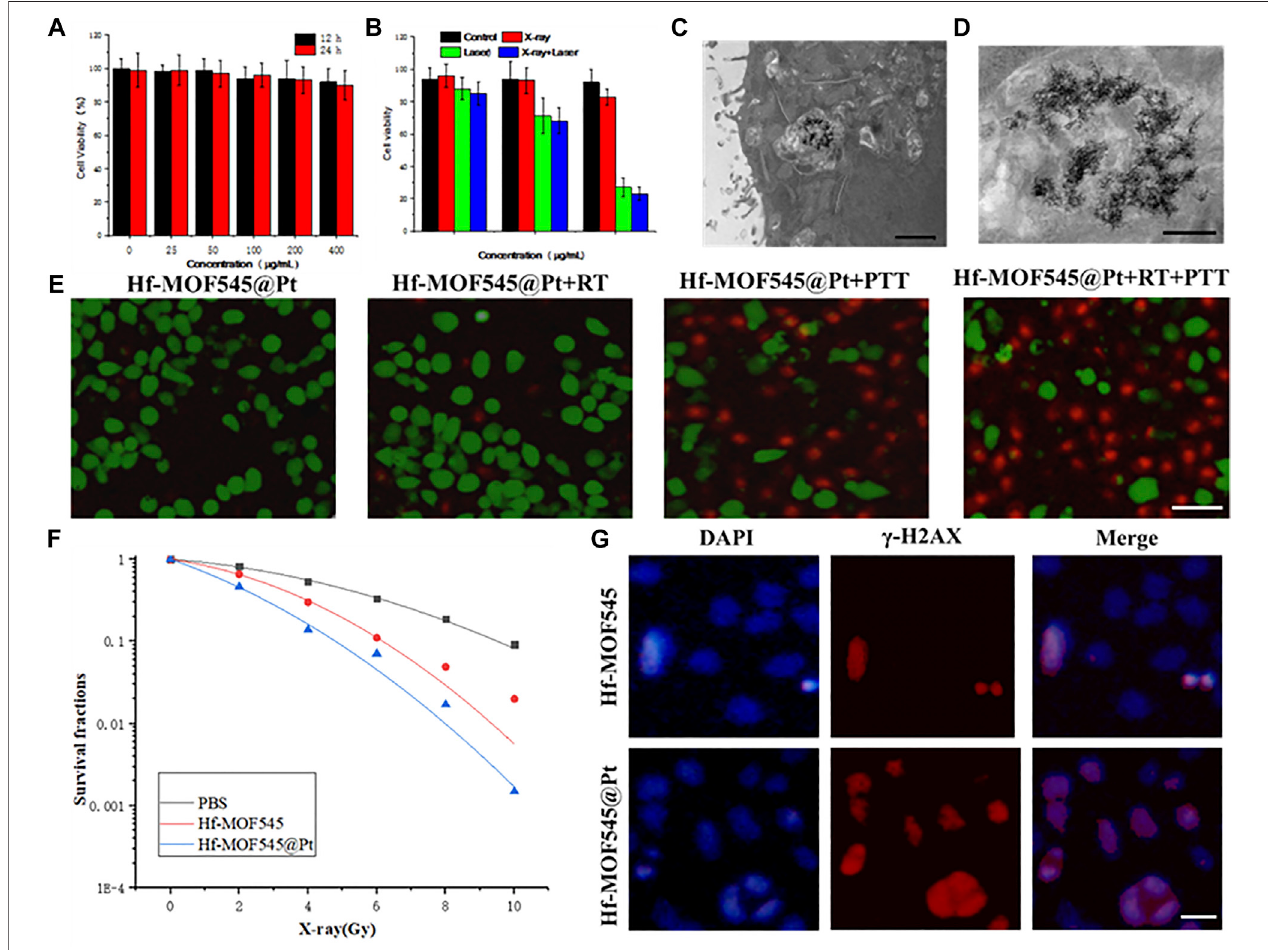
FIGURE 3 | In vitro cytotoxicity experiments. (A) 4T1 cells viabilities after incubation with different concentrations of NMOF545@Pt for 12 and 24 h; (B) 4T1 cells viabilities after different treatments with different concentrations of NMOF545@Pt: NMOF545@Pt, NMOF545@Pt + laser (0.75.0 W cm − 2 , 10 min), NMOF545@Pt + X-rays(4 Gy)and NMOF545@Pt +laser+X-rays; (C) and (D) arerepresentative TEMimagesofnanoparticles entrappedinvesicles of4T1cellsafter12 hofco-cultured with NMOF545@Pt, and the scale bar is 1 and 0.5 μ m for (C) and (D) , separately; (E) representative survival images of 4T1 cells after various treatment with NMOF545@Pt under PTT/RT. The green fl uorescence represents live cells, and the red fl uorescence represents dead cells, and the scale bar is 20 μ m; (F) radiation dose-survival curves of 4T1 cells cultured with different samples; (G) immunocytochemical analysis of γ -H2AX expressed in 4T1 cells and nucleus were stained with an anti- γ -H2AX antibody (red) and DAPI (blue) 24 h after RT, and the scale bar is 10 μ m.